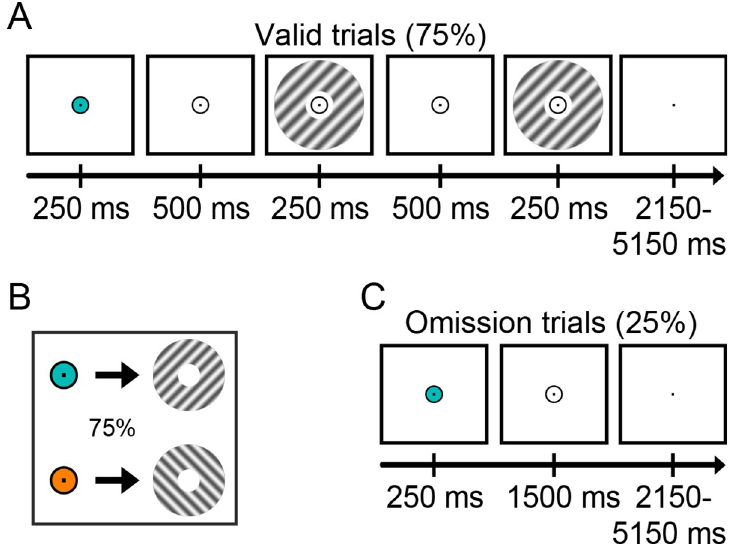
Fig 1. Experimental paradigm. (A) Each trial started with a coloured dot that predicted the orientation of the subsequent grating stimulus (45˚ or 135˚). On 75% of trials, a set of gratings was then presented, the first of which had the expected orientation and the second differed slightly in orientation and contrast. In separate experimental runs, participants discriminated either the orientation or the contrast difference between the gratings. (B) The colour of the fixation circle (cyan or orange) predicted the orientation of the subsequent grating stimulus (45˚ or 135˚) with 75% validity. (C) In the remaining 25% of trials, the gratings were omitted. On these trials, there was an expectation of a particular visual stimulus but no actual visual input. Participants had no task in these trials, except for holding central fixation.